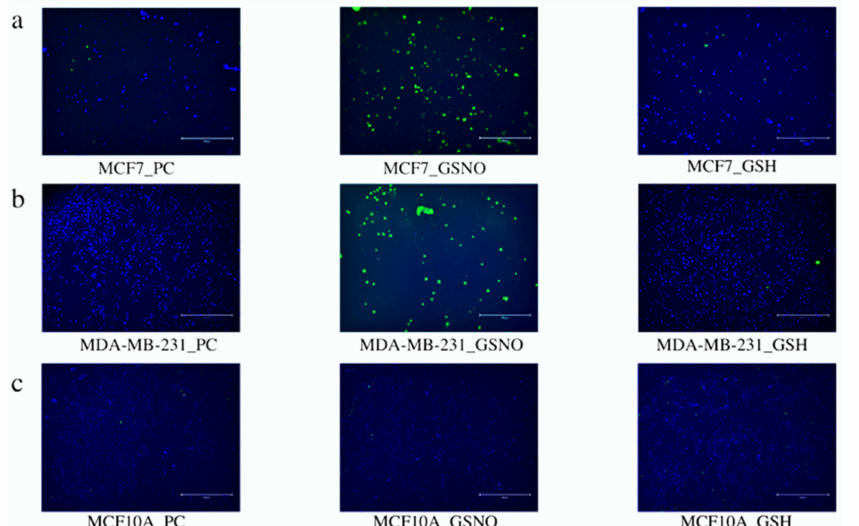
Figure 8. Live/dead cytotoxicity images for NO (Group 1) exposed MCF7 ( a ) and MDA-MB-231 ( b ) breast carcinoma cell lines as well as the normal breast cell line MCF10A ( c ). Images were captured using fluorescence microscopy. Live cells exhibited blue fluorescence and dead cells exhibited green fluorescence. For each cell line, the images on the left-hand side represent untreated PC cells, the images in the middle represent the S (Group 1) cells, and the images on the far right represent GSH-treated